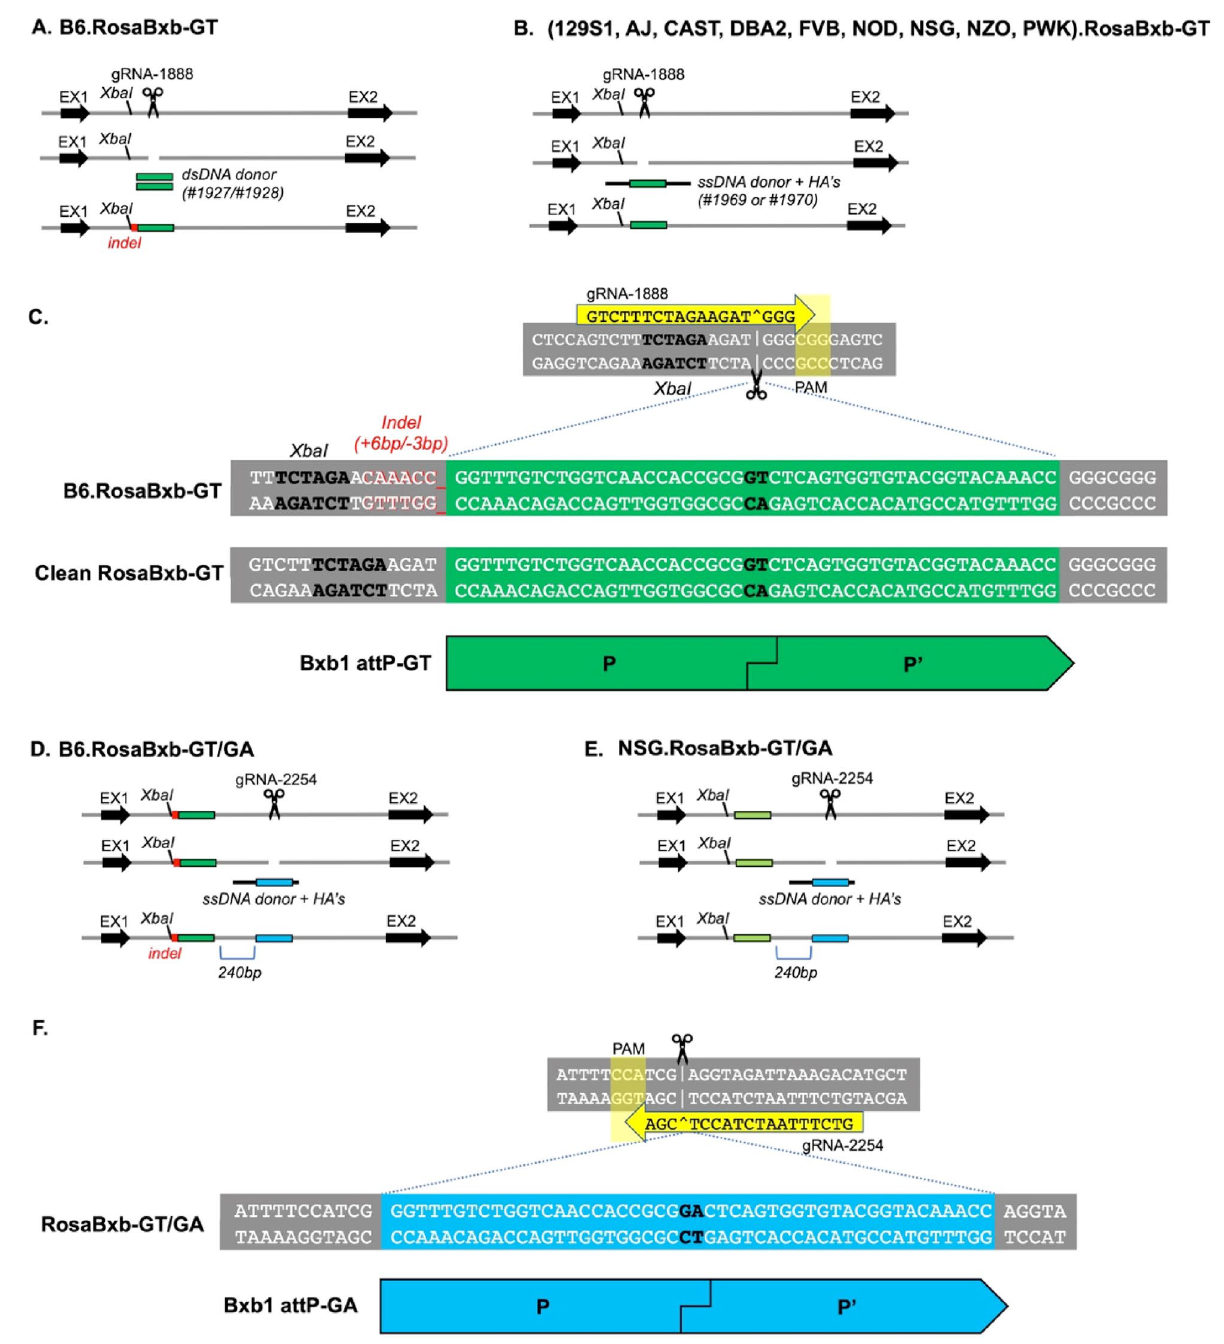
Figure 2. Construction of RosaBxb-GT alleles on multiple genetic backgrounds. ( A ) For the mouse strain B6 only, a CRISPR/Cas9 GUIDE-seq strategy was used resulting in the insertion of the attP-GT site with an indel. ( B ) For all other backgrounds a CRISPR/Cas9 mediated HDR strategy was used, resulting in scarless incorporation of the attP site to generate the RosaBxb-GT alleles. ( C ) Sequence of Bxb1 attP-GT site for B6.RosaBxb1-GT, showed that an indel occurred in B6 (only) and the correct RosaBxb-GT allele with perfect integration occurred in mouse strains 129S1.RosaBxb-GT, AJ.RosaBxb-GT, CAST.RosaBxb-GT, DBA2. RosaBxb-GT, FVB.RosaBxb-GT, NOD.RosaBxb-GT, NSG.RosaBxb-GT, NZO.RosaBxb-GT, and PWK. RosaBxb-GT. Generation of RosaBxb-GT/GA alleles on B6 ( D ) and NSG ( E ) genetic backgrounds using a CRISPR/Cas9 HDR strategy wherein the attP-GA site was placed 240 bp 3’ of the attP-GT site, using gRNA #2254 and asymmetric donor oligo #2255. ( F ) Sequence detail of the Bxb1 attP-GA site region in strains B6.RosaBxb1-GT/GA and